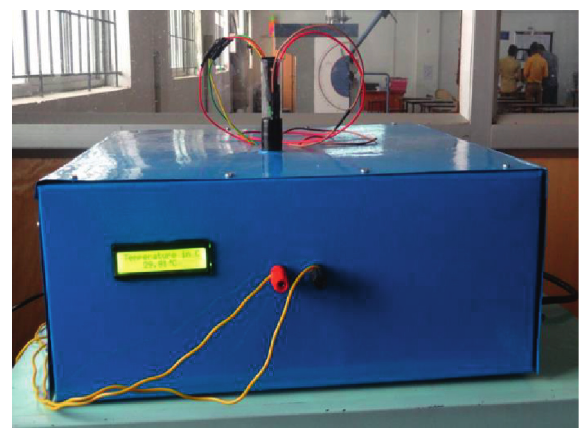
Figure 3: Thermal conductivity-measuring